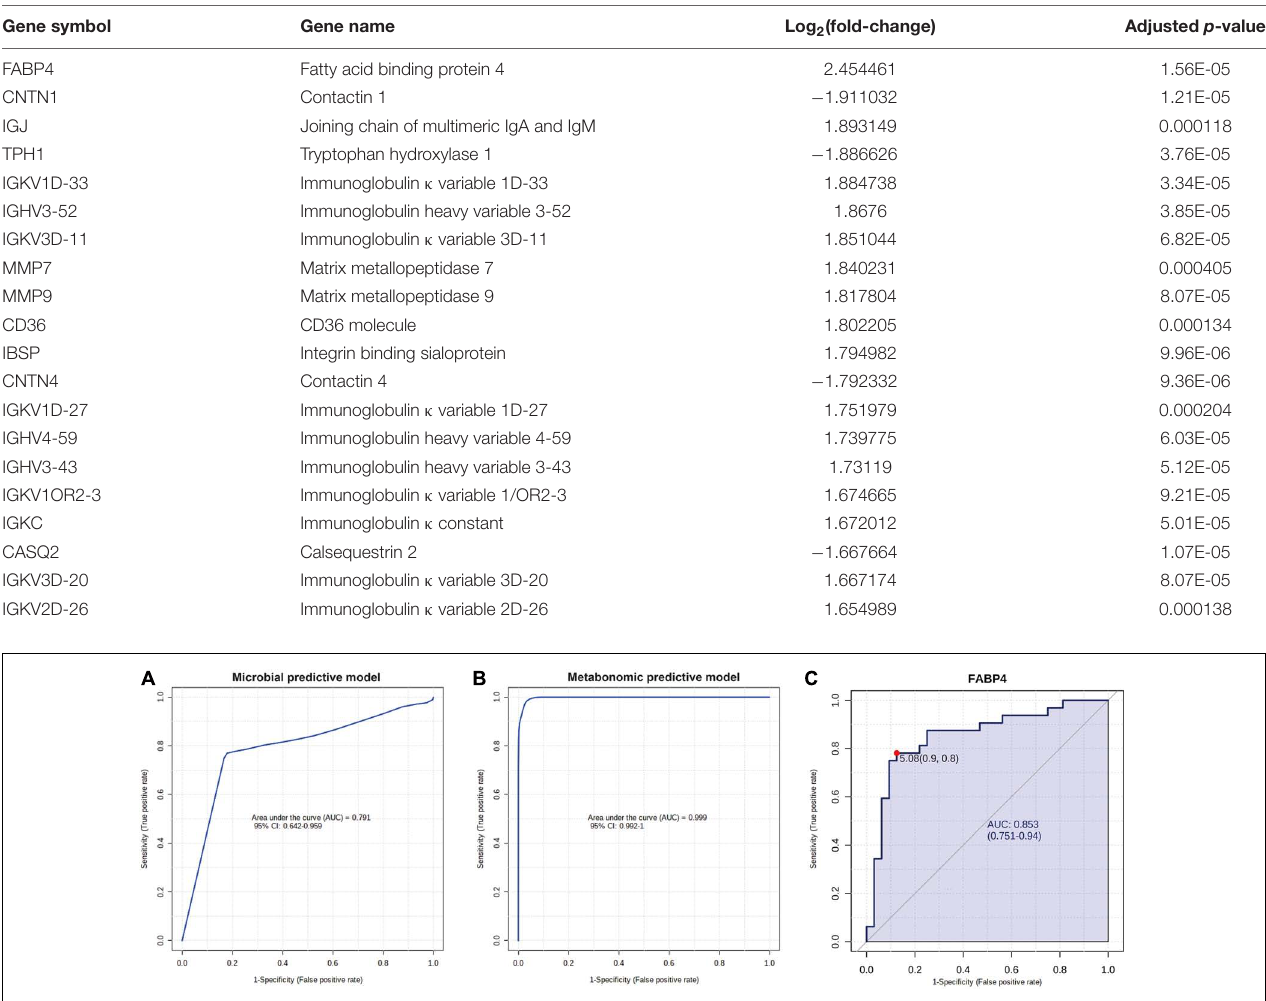
Frontiers in Physiology |